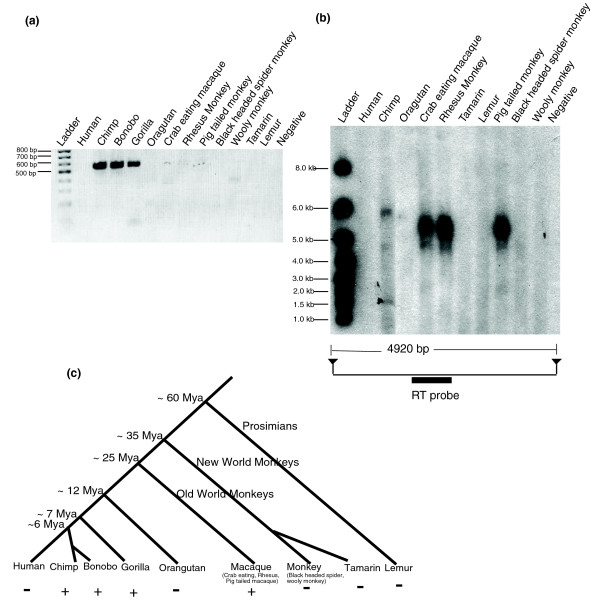
Distribution of CERV 2 elements among primates. Species surveyed include human (Homo sapiens), chimpanzee (Pan troglodytes), bonobo (Pan paniscus), gorilla (Gorilla gorilla), orangutan (Pongo pygmaeus), crab eating monkey (Macaca fascicularis), rhesus monkey (Macaca mulatto), pig tailed monkey (Macaca nemestrina), black headed spider monkey (Ateles geoffroyi), wooly monkey (Lagothrix lagotricha), red-chested mustached tamari (Saguinus labiatus), and ring-tailed lemur (Lemur catta). (a) PCR was conducted using primers designed in the RT region of chimpanzee CERV 2 element. The PCR results indicate that the CERV 2 element is present in chimpanzee, bonobo, gorilla and absent in other primates. (b) Southern hybridization was carried out on the DNA of the primates with negative PCR results using a probe designed in the RT region. The results indicate that CERV 2 like elements are present in chimpanzee, crab eating macaque, rhesus monkey and pig tailed monkey. Though the same amount of DNA was loaded in all lanes, the strength of hybridization is higher in old world monkeys than in chimpanzees, suggesting a higher copy number of CERV 2 elements in old world monkeys than in chimpanzees. Below the figure, a restriction map (chimpanzee sequence from chromosome 5 position 53871447.. 53880194 (NCBI build 1 version 1)) is presented in relation to the hybridization probe, HindIII (triangles). (c) The results from the combined PCR and Southern analyses demonstrate a patchy distribution of CERV 2 elements among primates.